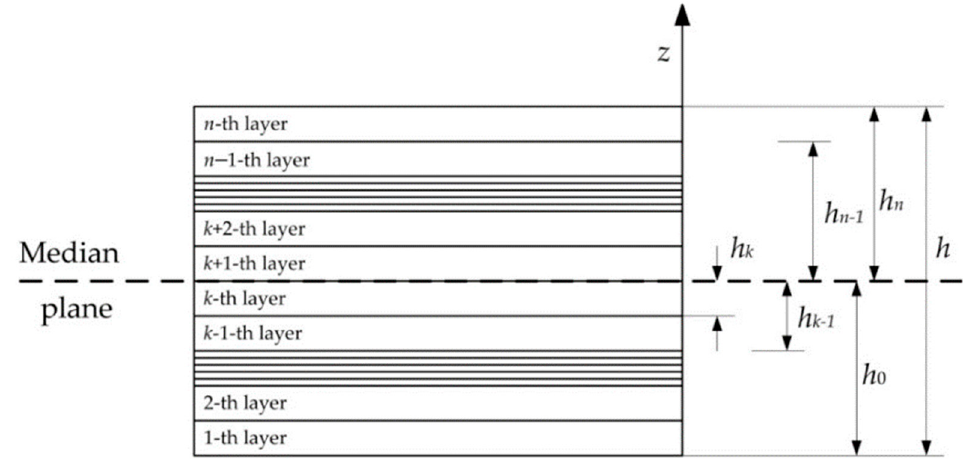
Figure 2. Coordinates of layers.